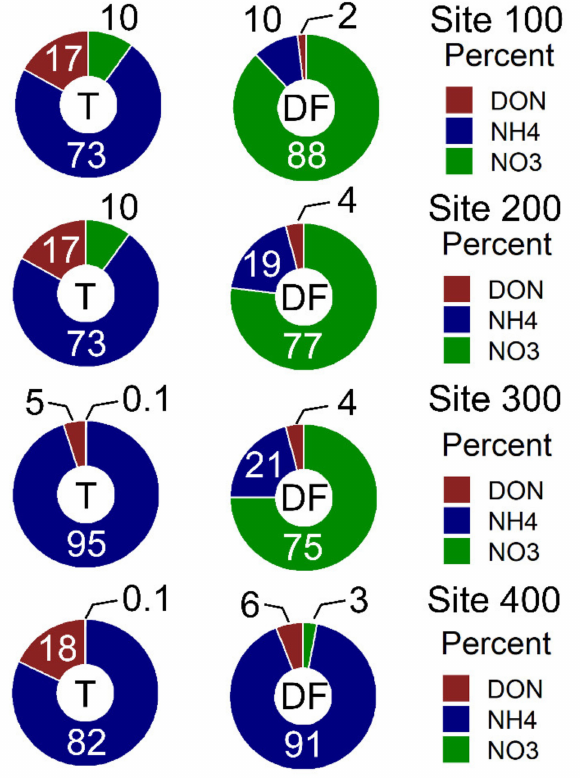
Figure 4. Mean percentages of total dissolved nitrogen in wastewater sampled from the septic tanks (T), and in groundwater near (<3 m) the drainfield (DF) of each site that was dissolved organic (DON), ammonium (NH 4+ ) and nitrate (NO 3 − ) for Sites 100 to